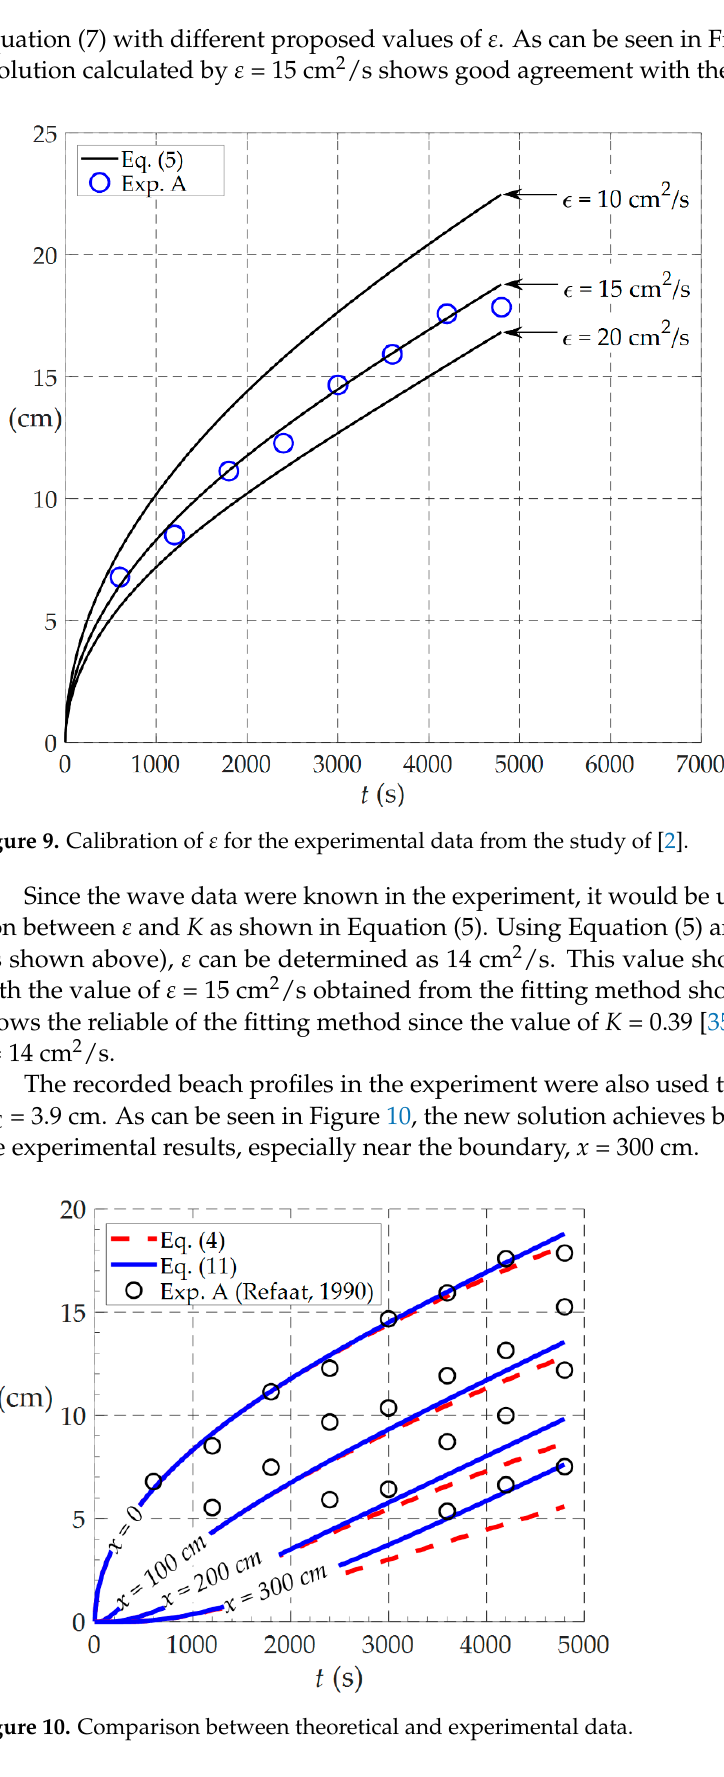
Figure 8. Schematic diagram of experiment for formation of river deltas [2]. ( a ) Plane view; ( b ) Side view.